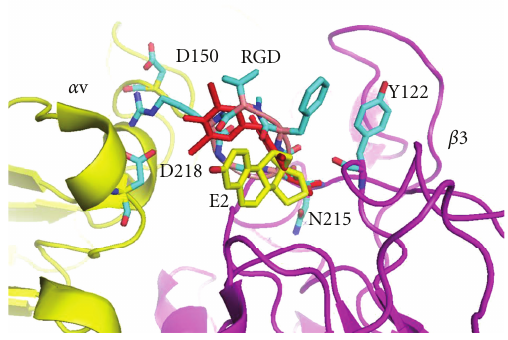
Figure 3: Crystal structure of α v β 3 integrin (yellow/violet) with RGD cyclic peptide (cyan) (1I5g.pdb) with T 4 Ac (red) and estradiol (E2, yellow) modeled into the RGD binding pocket. Residues Asp150 and Asp218 in the α v domain and Tyr122 and Asn215 in the β 3 domain are labeled for orientation. Figure drawn with PyMol.